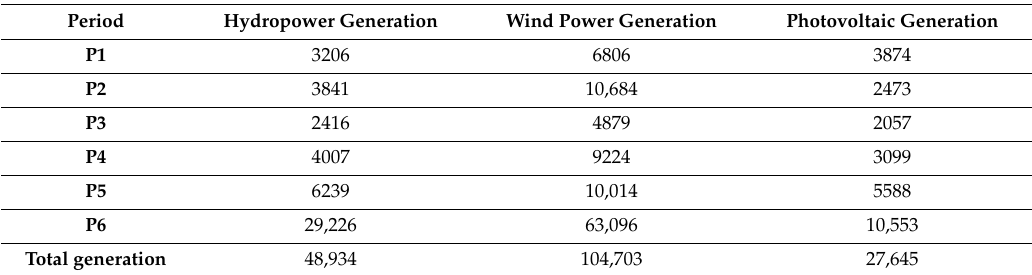
Table A4. Annual generation data according to hourly periods